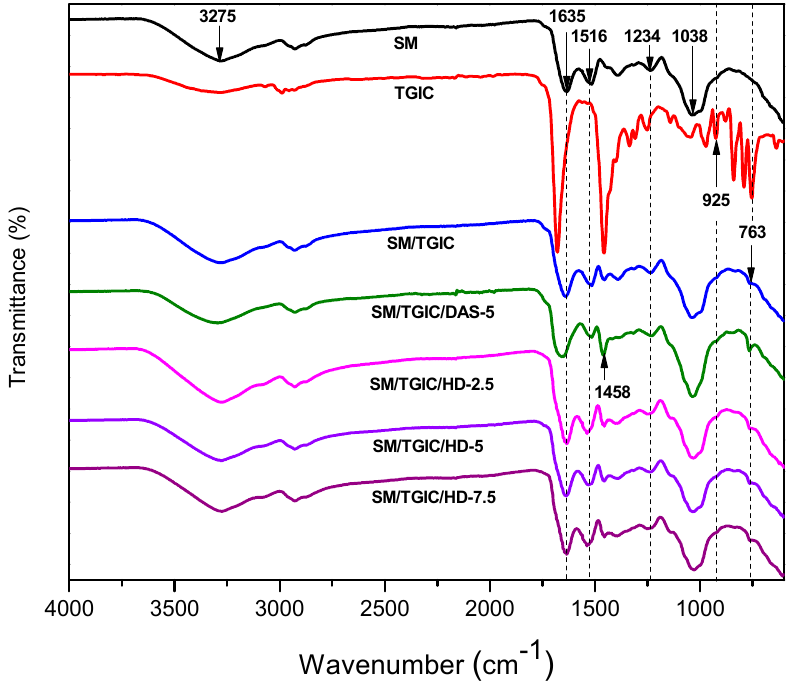
Figure 3. The attenuated total reflectance-fourier transform infrared spectroscopy (ATR-FTIR) spectra of the resulting adhesives.